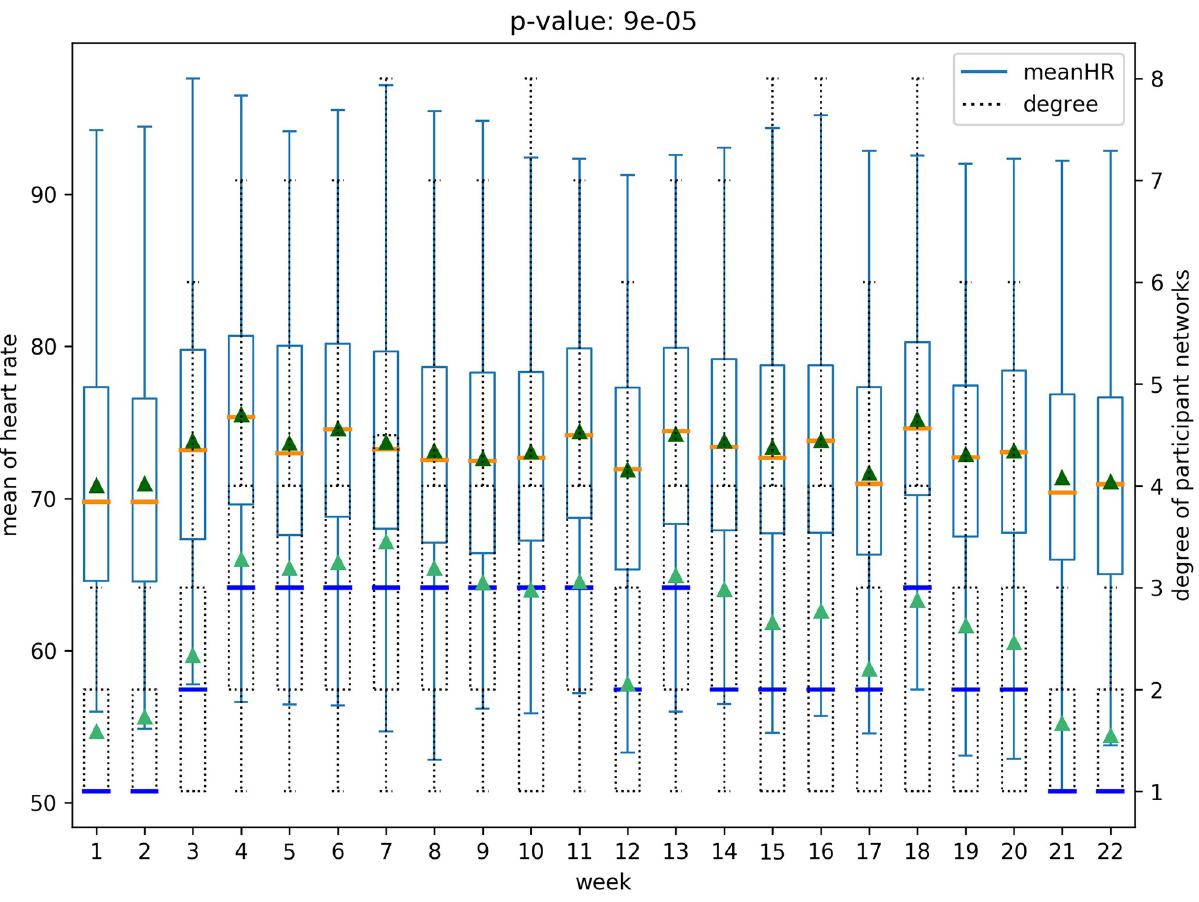
Fig 1. Main result for the relation between network structure and health